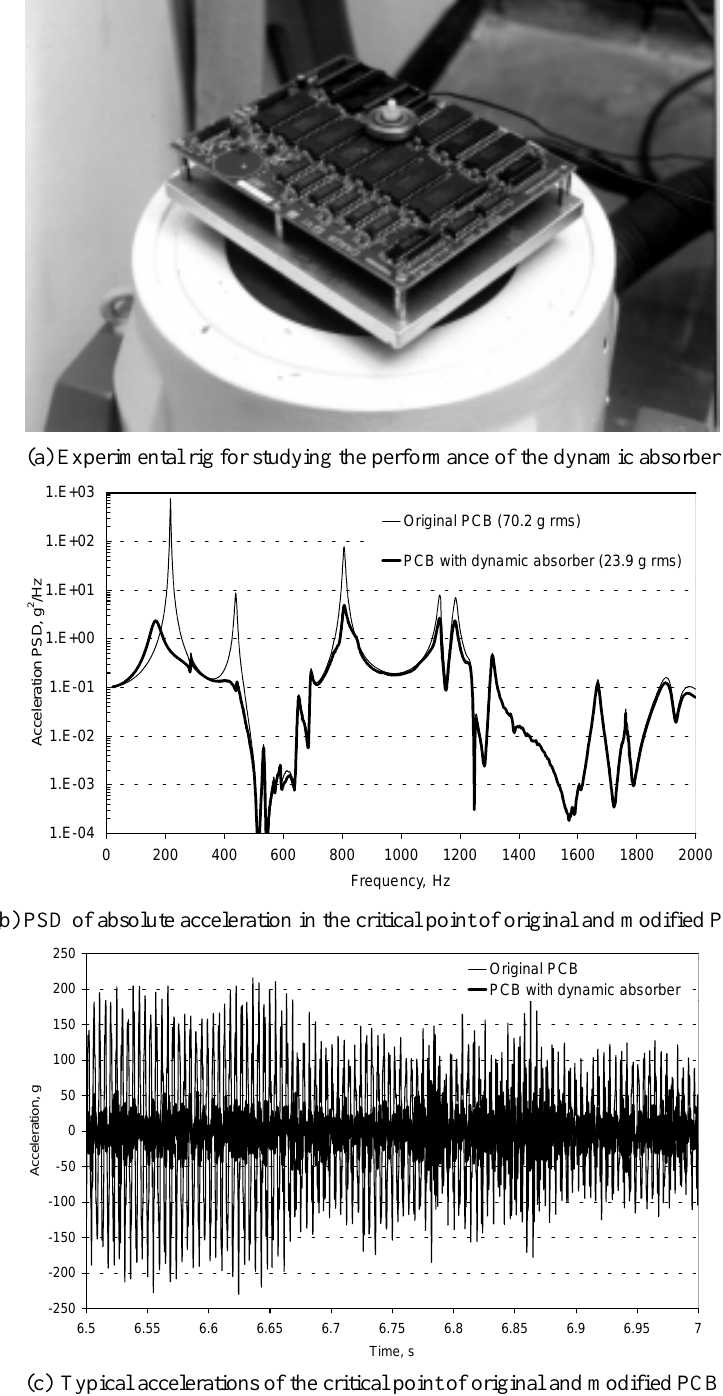
Fig. 8. Performance of dynamic absorber in frequency and time domains. a) Experimental rig for studying the performance of the dynamic absorber; b) PSD of absolute acceleration in the critical point of original and modified PCB; c) Typical accelerations of the critical point of original and modified